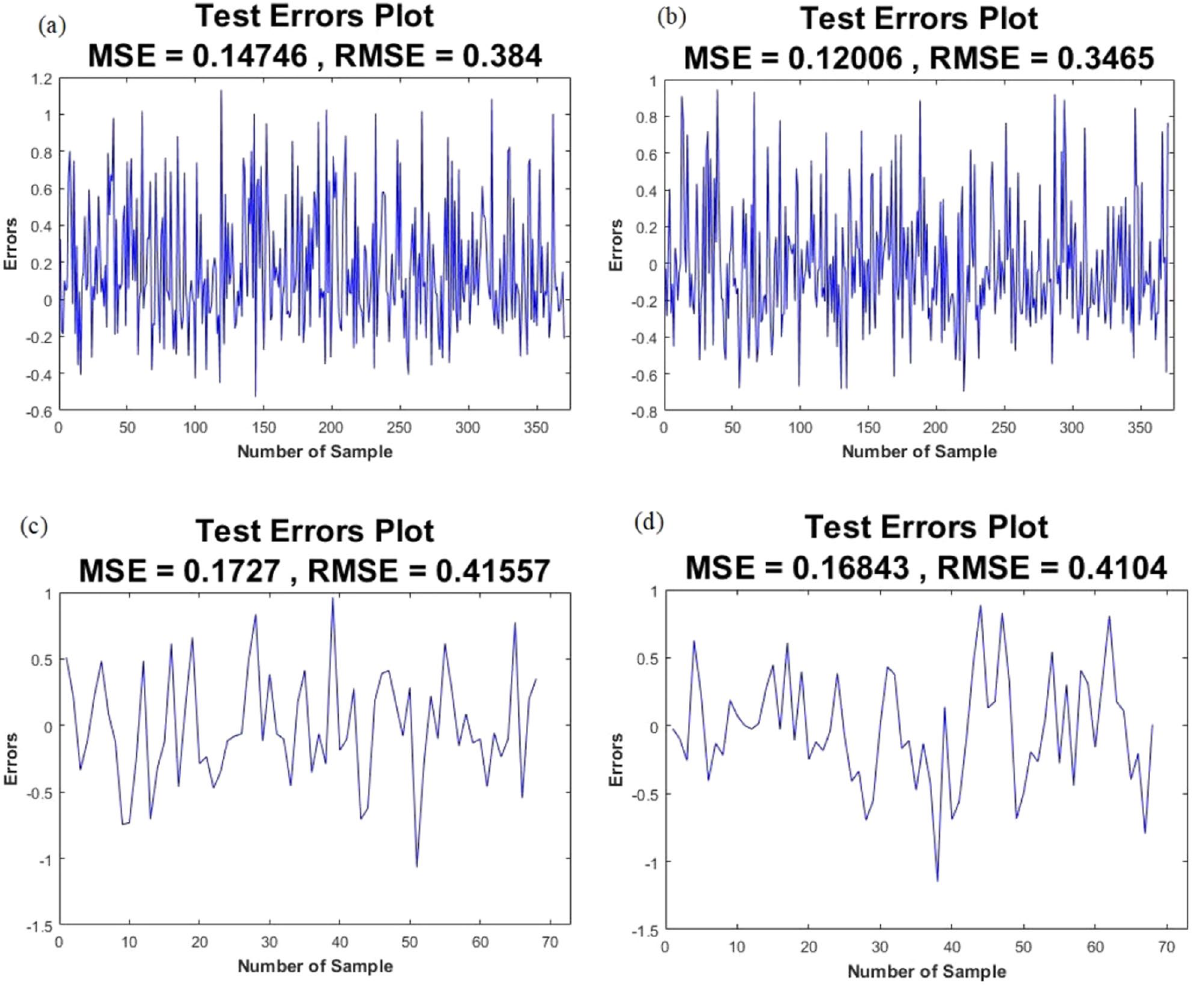
Figure 2. MSE and RMSE values of testing step for: ( a ) SAGF, ( b ) SAPF, ( c ) SAGL, ( d )